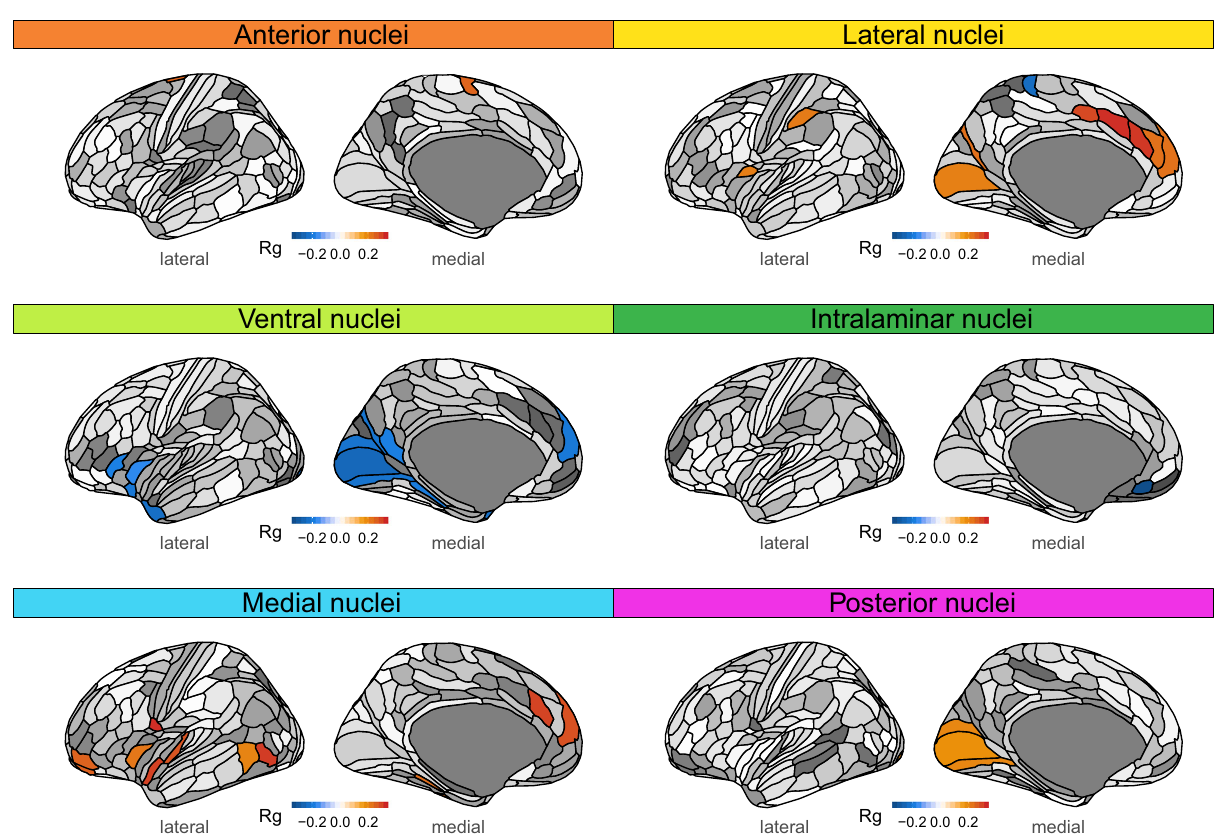
Fig. 3 Thalamocortical genetic relationships. We found signi fi cant genetic correlations between all thalamic nuclei and distinct cortical regions. There were signi fi cant positive genetic correlations between anterior nuclei and medial premotor cortex; between lateral nuclei and mainly medial prefrontal, anterior cingulate, parietal, and visual cortices; between medial nuclei and prefrontal and temporal cortices; and between posterior nuclei and visual cortices. We also found signi fi cant negative genetic associations between ventral nuclei and visual, prefrontal, and temporal cortical regions, and between intralaminar nuclei and rostral medial prefrontal cortex. Warm and cool colors in cortical regions indicate signi fi cant positive and negative genetic correlations, respectively, after adjusting for analyses of 180 cortical regions and 6 volumes (two-sided P < FDR). Corresponding statistics are provided in Supplementary Data 15. FDR, false discovery rate; Rg, genetic